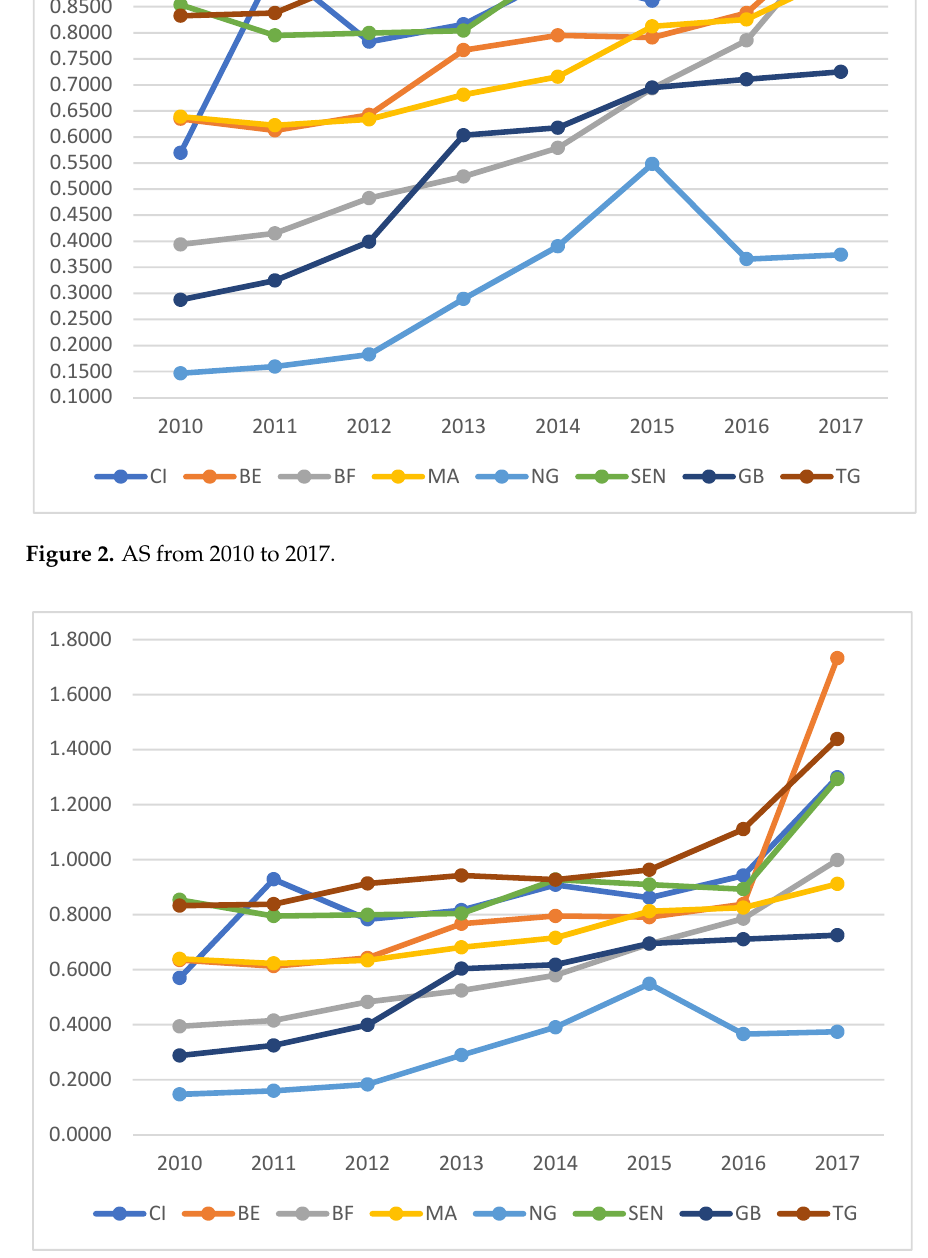
Figure 3. AS–SE from 2010 to 2017.